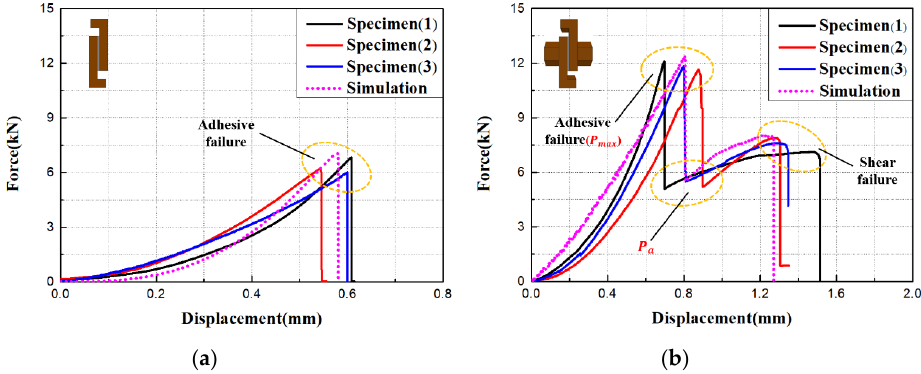
Figure 9. Test and simulation load–displacement curve: ( a ) bonded joints; ( b ) hybrid joints.